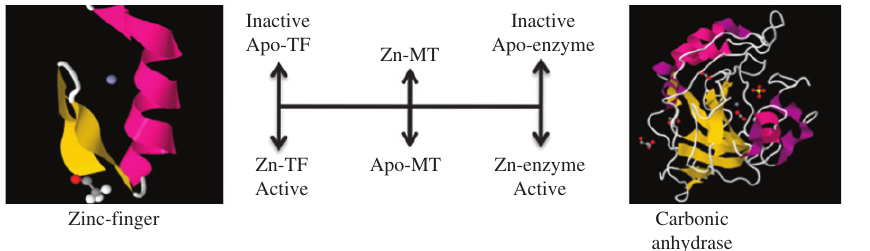
Figure 6 The possibility to load/unload Zn(II) from zinc-requiring proteins exerted by MTs confers them the role of regulators of the activity of multiple enzymes and transcription factors, here represented by a canonical Zn finger loop (1ZNF PDB entry) and the human carbonic anhy- drase (2VVA PDB entry). All protein structures have been represented using Jmol, an open source Java viewer available at